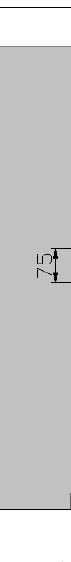
Figure 13. Sampling points (unit: mm).